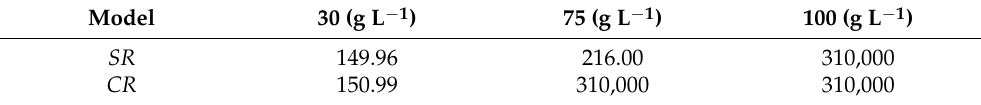
Table A3. Apparent substrate transport turnover numbers (nmol min − 1 mg − 1 models according to the initial fermentation concentration.